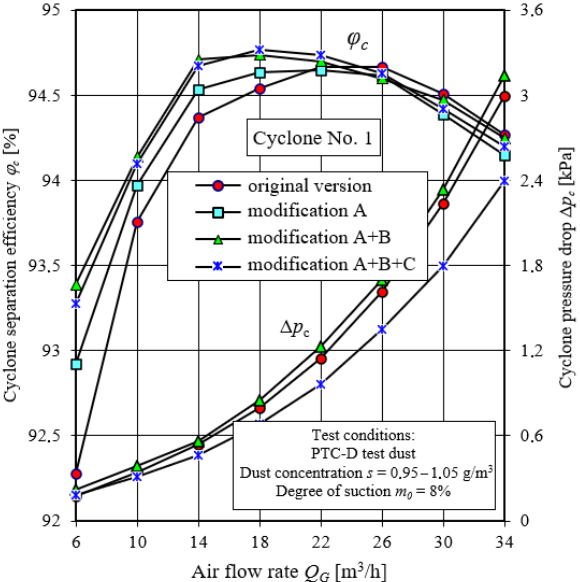
Figure 36. Change in separation efficiency ϕ c = f ( Q G ) and pressure drop ∆ p c = f ( Q G ) of cyclone D -40 (No. 1) for successive A, B and C cyclone design modification elements.